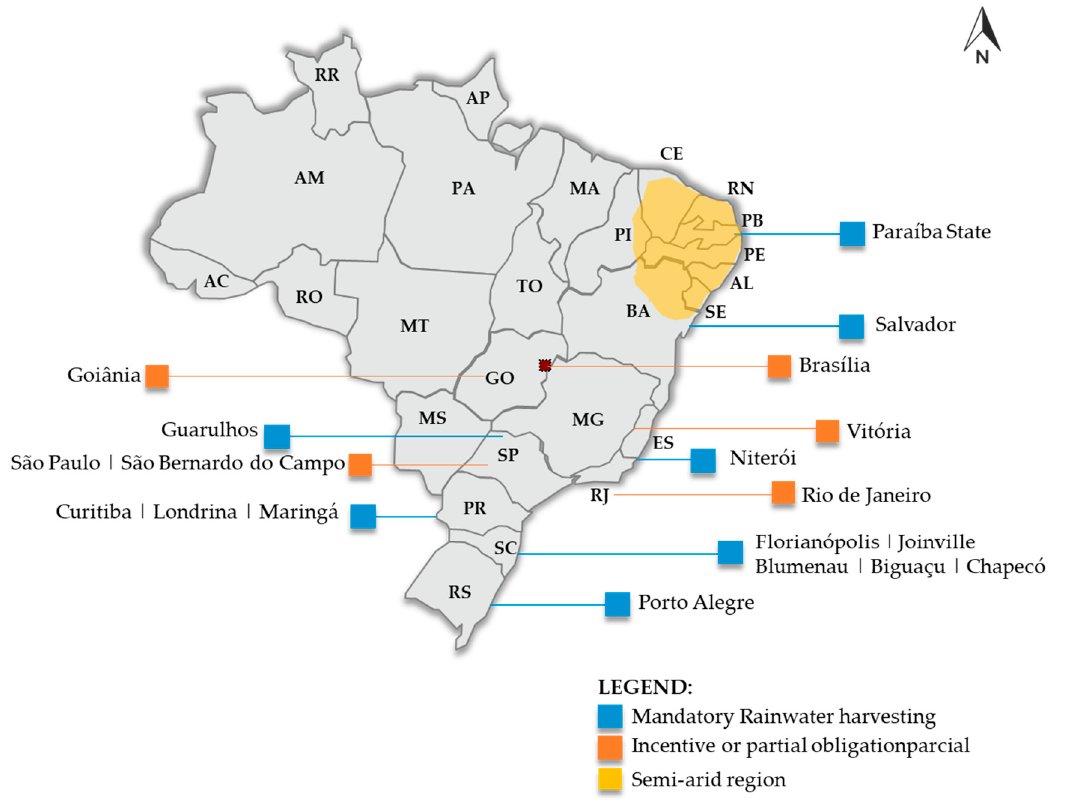
Figure 6. Map identifying cities with own legislation related to rainwater harvesting or water